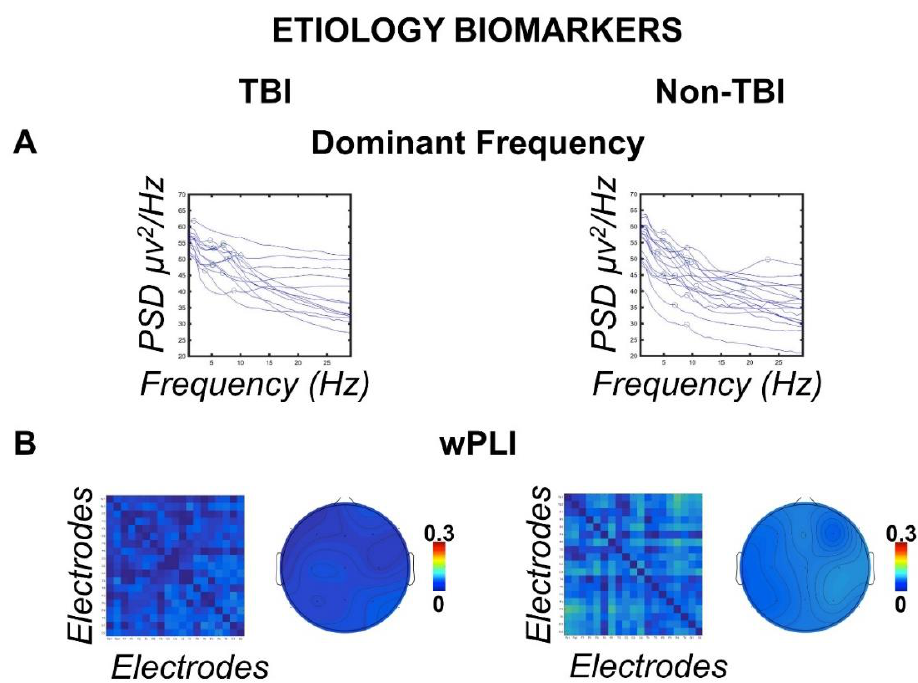
Figure 1. Etiology biomarkers. ( A ) Single-subject power spectral density (PSD) in the frequency range (1–30 Hz) divided into traumatic (TBI) and nontraumatic (non-TBI) etiologies. The circles identify the dominant frequency peaks showing a distribution of the peaks toward slower frequencies in the TBI group. ( B ) Connectivity matrices between scalp electrodes of the weighted phase lag index (wPLI) for TBI and non-TBI groups showing stronger global connectivity in the non-TBI group. Topographies show the grand mean wPLI connectomes for each